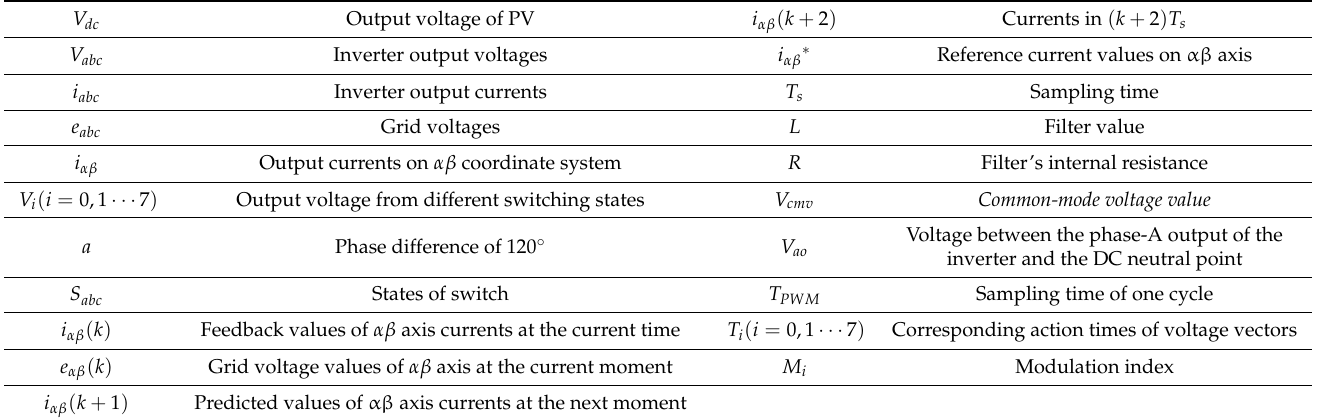
Table A2. Definition of notations in